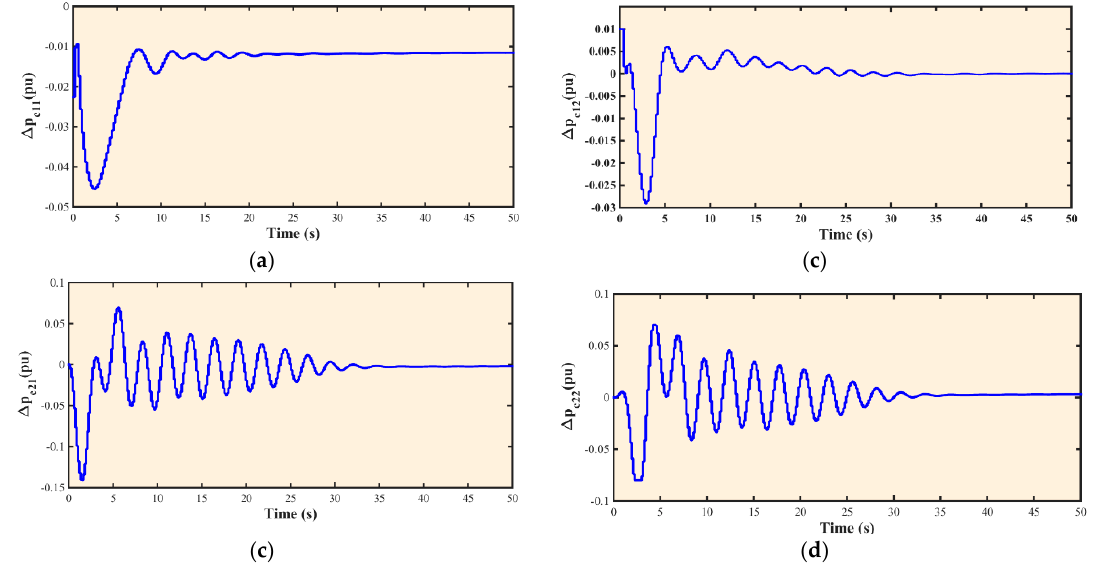
Figure 7. Control signal of MPC for: ( a ) AGC 1, ( b ) AGC 2, ( c ) HPWH 1 and ( d ) HPWH 2.